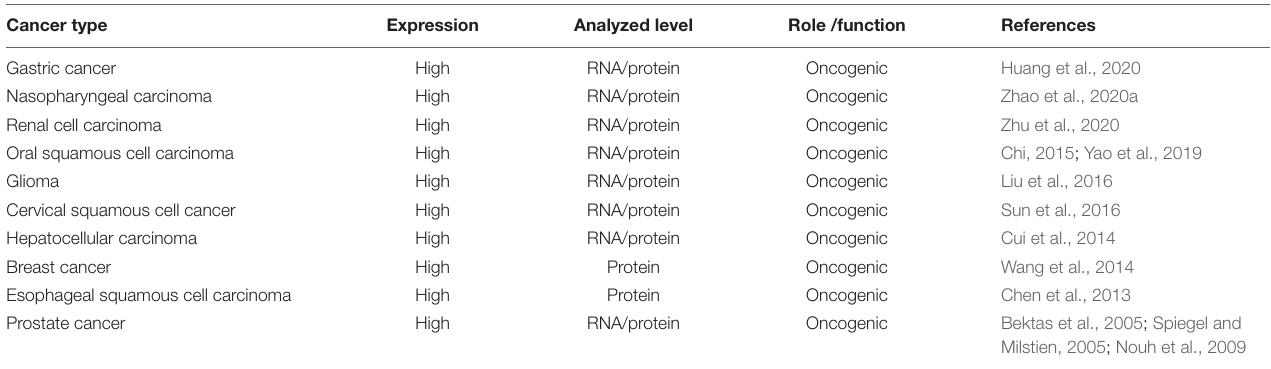
FIGURE 6 | Alteration frequency in AGK gene across various cancers. All these data are concluded in cBioPortal, from TCGA Pan-Cancer Atlas Studies which cover 10,953 patients/10,967 samples. TABLE 2 | Expression of AGK in human tumor tissue compared with